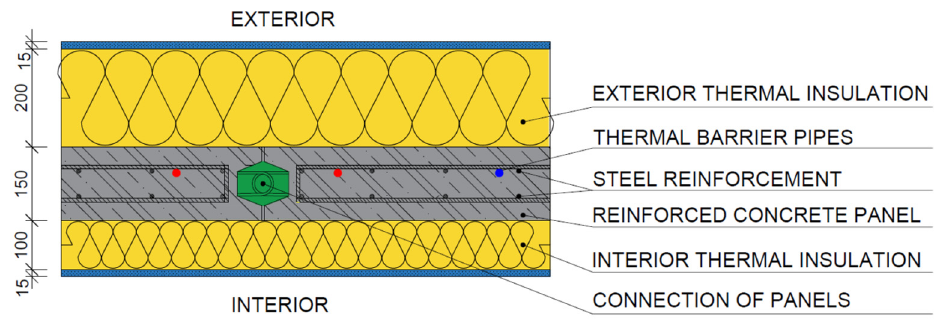
Figure 11. “Detail A”, the corner joint of two perimeter panels. The colored points (red) in the pic- ture are thermal barrier pipes.